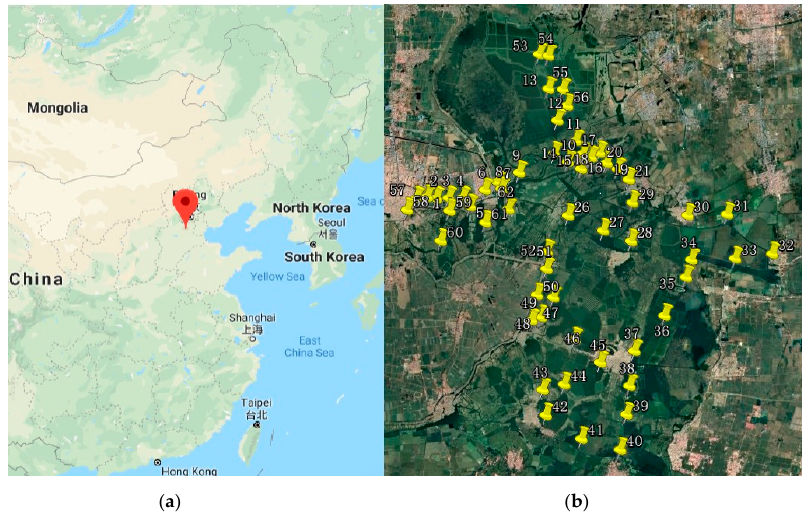
Figure 3. ( a ) Location of Baiyangdian area in North China; and ( b ) Locations of water samples at Baiyangdian area.